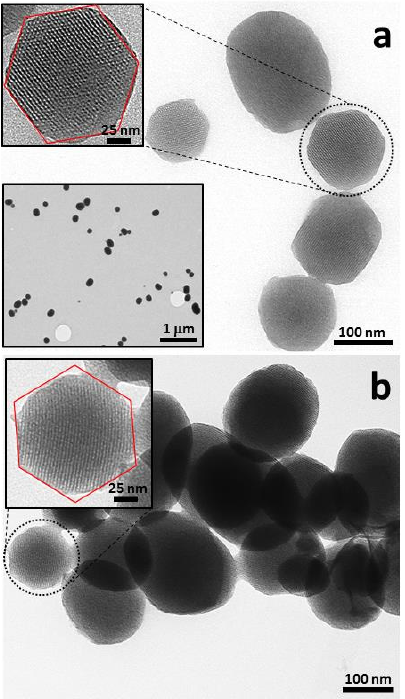
Figure 2. Powder X-ray diffraction (PXRD) patterns of the starting MCM-41 ( a ) and the S1 solid ( b ). A schematic representation of the hexagonal ordered mesoporous array, including the unit cell typical of the MCM-41 silica is presented.